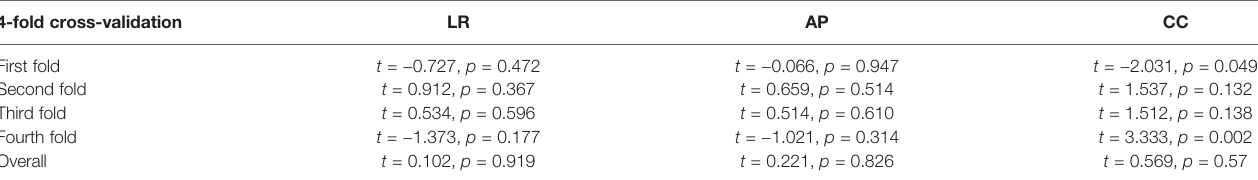
TABLE 2 | Position differences between the predicted and ground truth tumors.